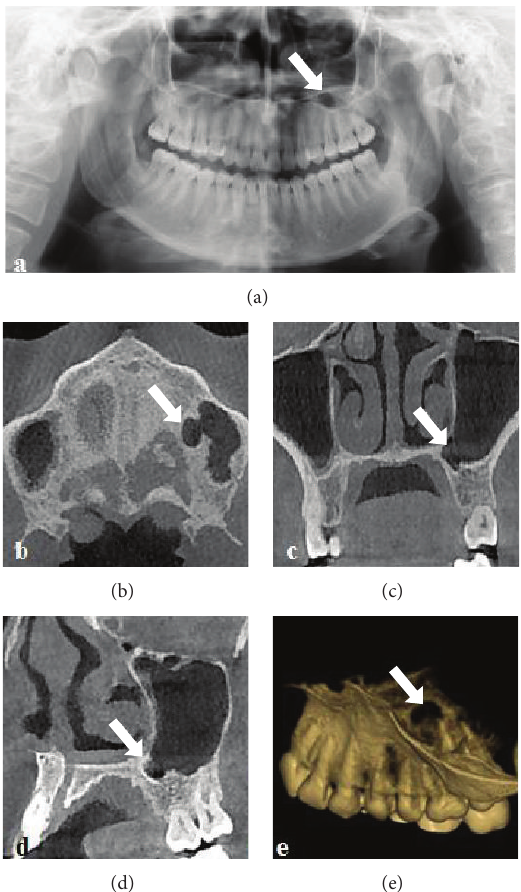
Figure 2: Panoramic radiograph showing well-defined periapical radiolucency in relation to apices of the maxillary left second premolarandfirstmolar(a).Axial(b),coronal(c),sagittal,andthree dimensional view of the anatomical variation of maxillary